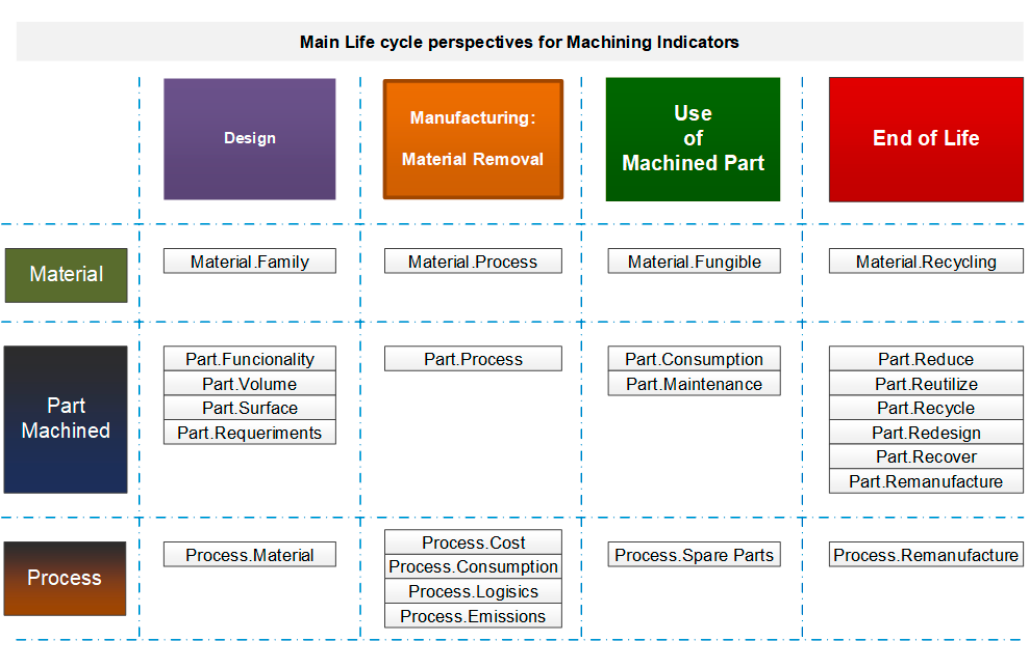
Table 3. General and specific information on sustainable machining indicators.